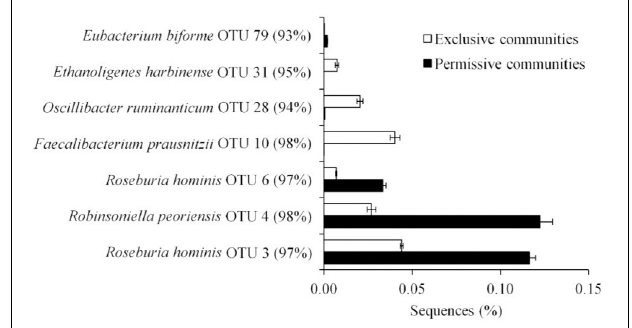
FIGURE 5 | OTUs representing more than 0.01% of the total sequences and significantly ( P < 0.05) associated with Salmonella exclusive and permissive cecal communities identified by